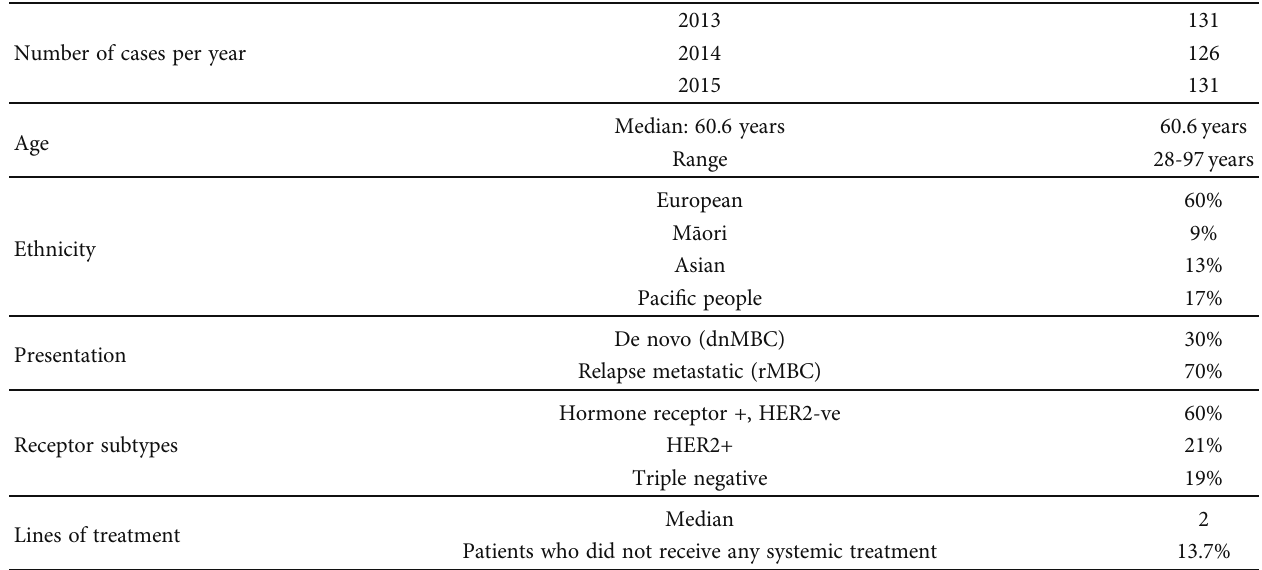
Table 1: Key demographic and disease features of patients diagnosed with ABC in Auckland 2013-2015.